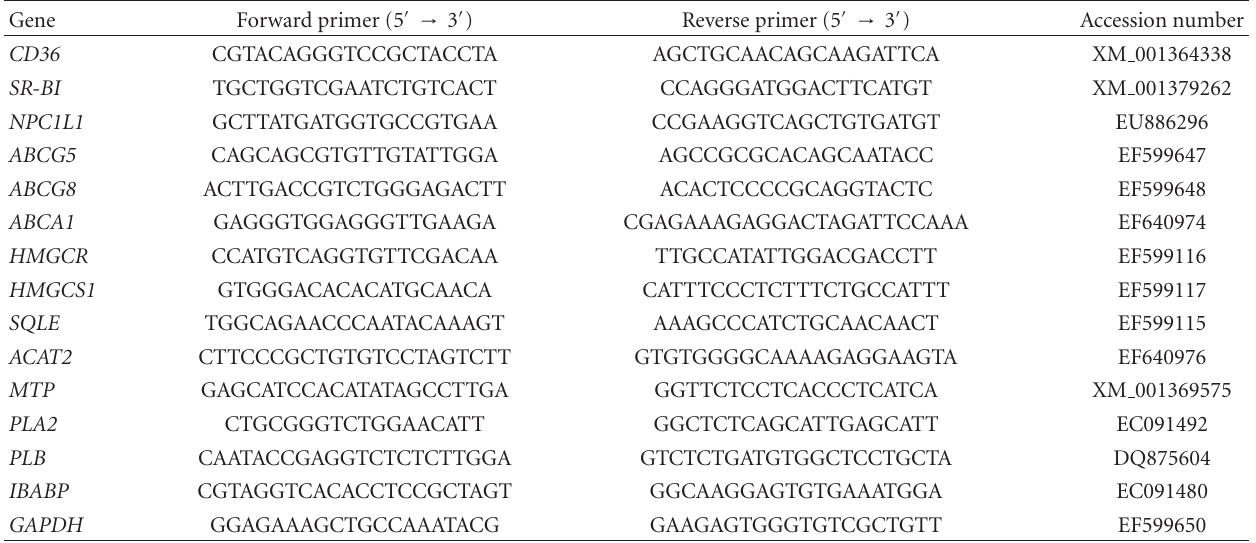
Table 1: Primer sequences and accession